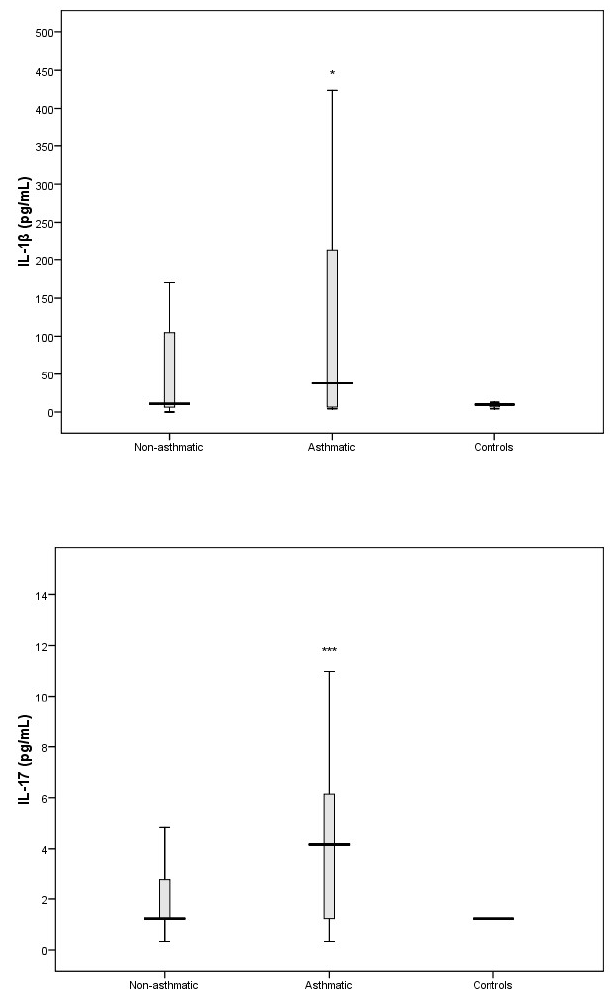
Figure 4. Levels of IL-1 β and IL-17 in nasal secretions of non-respiratory disease controls, and RV-C-infected patients with asthma and without asthma. IL-1 β and IL-17 were only elevated in the asthma patient group compared to controls. * p < 0.05, *** p < 0.001. Overall, RV-C-infected children with pre-existing asthma displayed a cytokine profile characterised by elevated levels of Th2, Th17, and pro-inflammatory responses. However, cytokine levels of Th1 responses and interferon responses displayed no significant changes compared to healthy